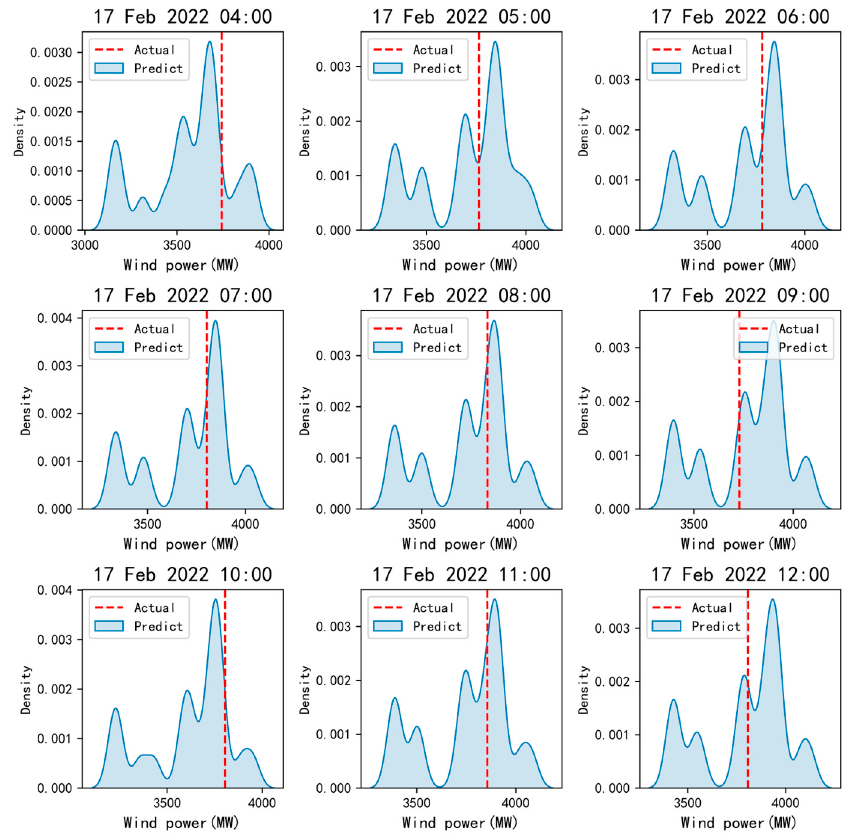
Figure 10. Probability density curves of the wind power for the partial test set.